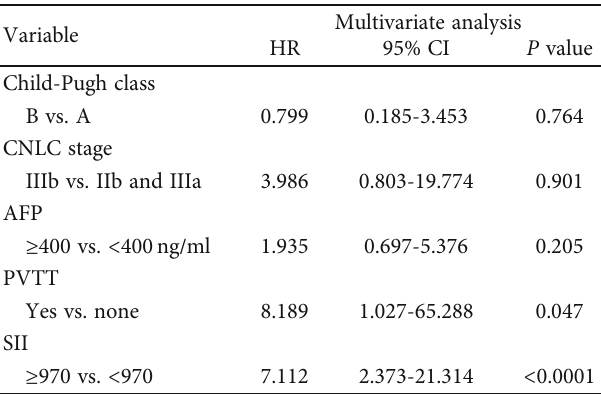
Table 3: Multivariate Cox proportional hazards regression models for progression-free survival.